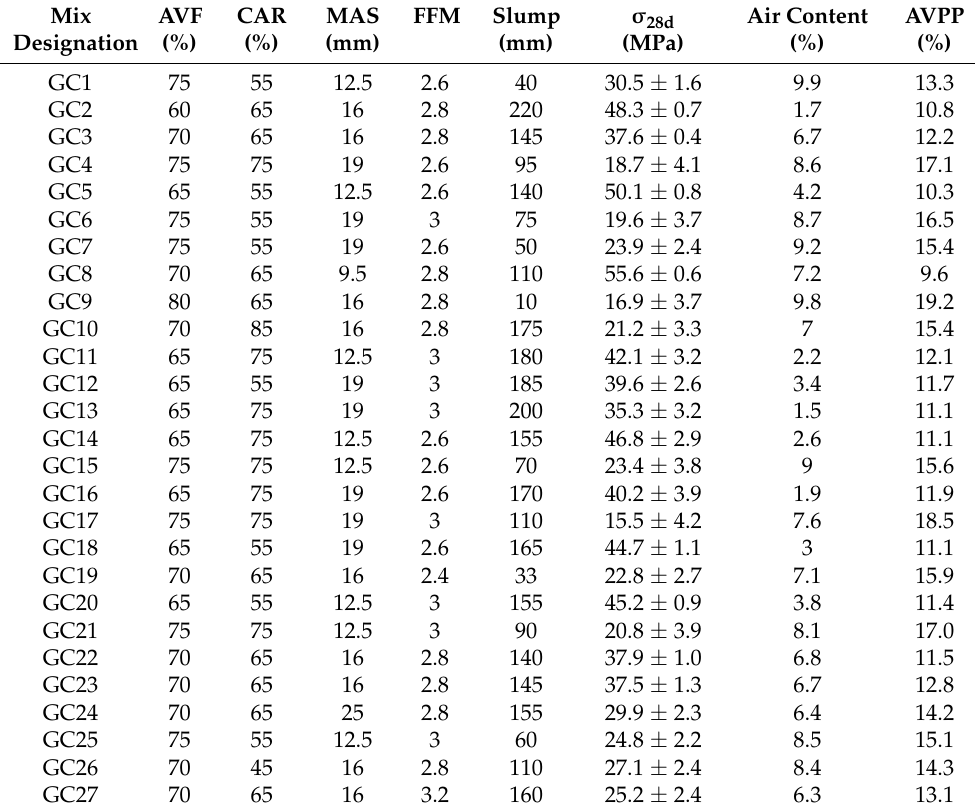
Table 3. Matrix of experimental design and measured responses of geopolymer concrete mixes using central composite